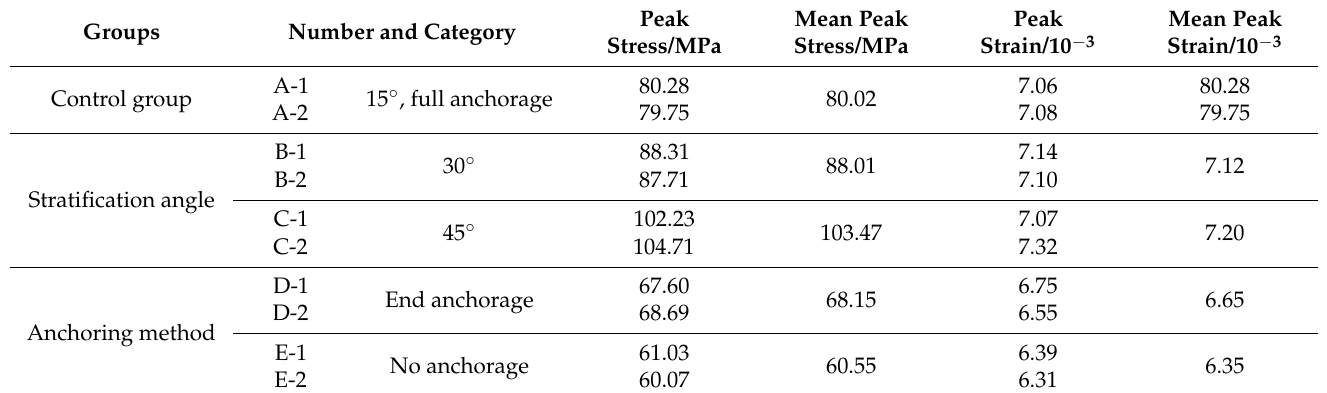
Table 3. Dynamic strength and peak strain of anchorage rock